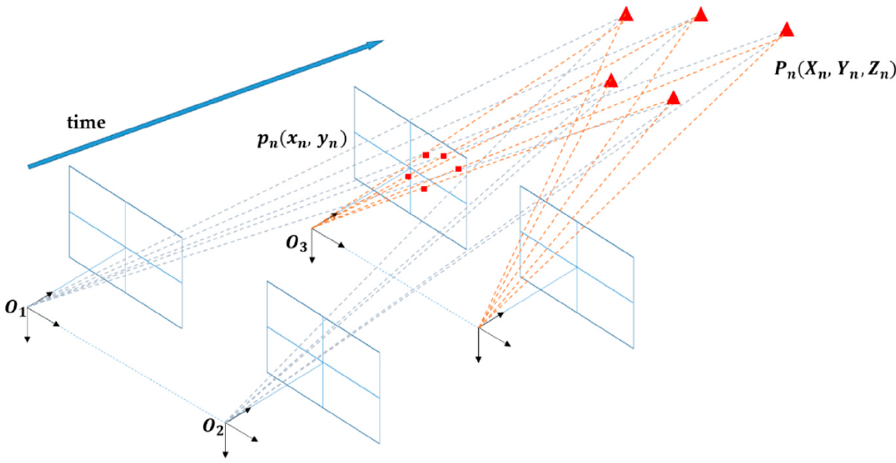
Figure 7. Absolute orientation in mobile mapping system (MMS).